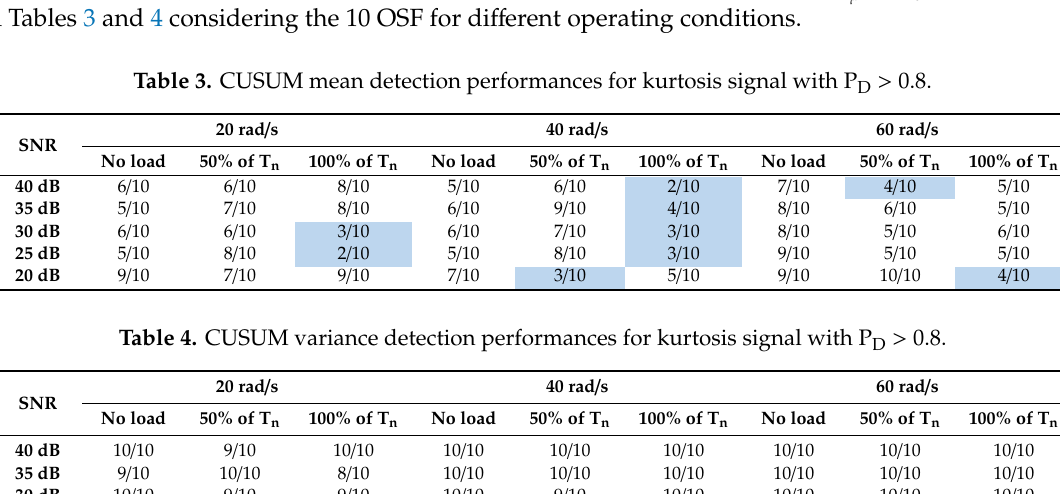
Table 3. CUSUM mean detection performances for kurtosis signal with P D > 0.8.